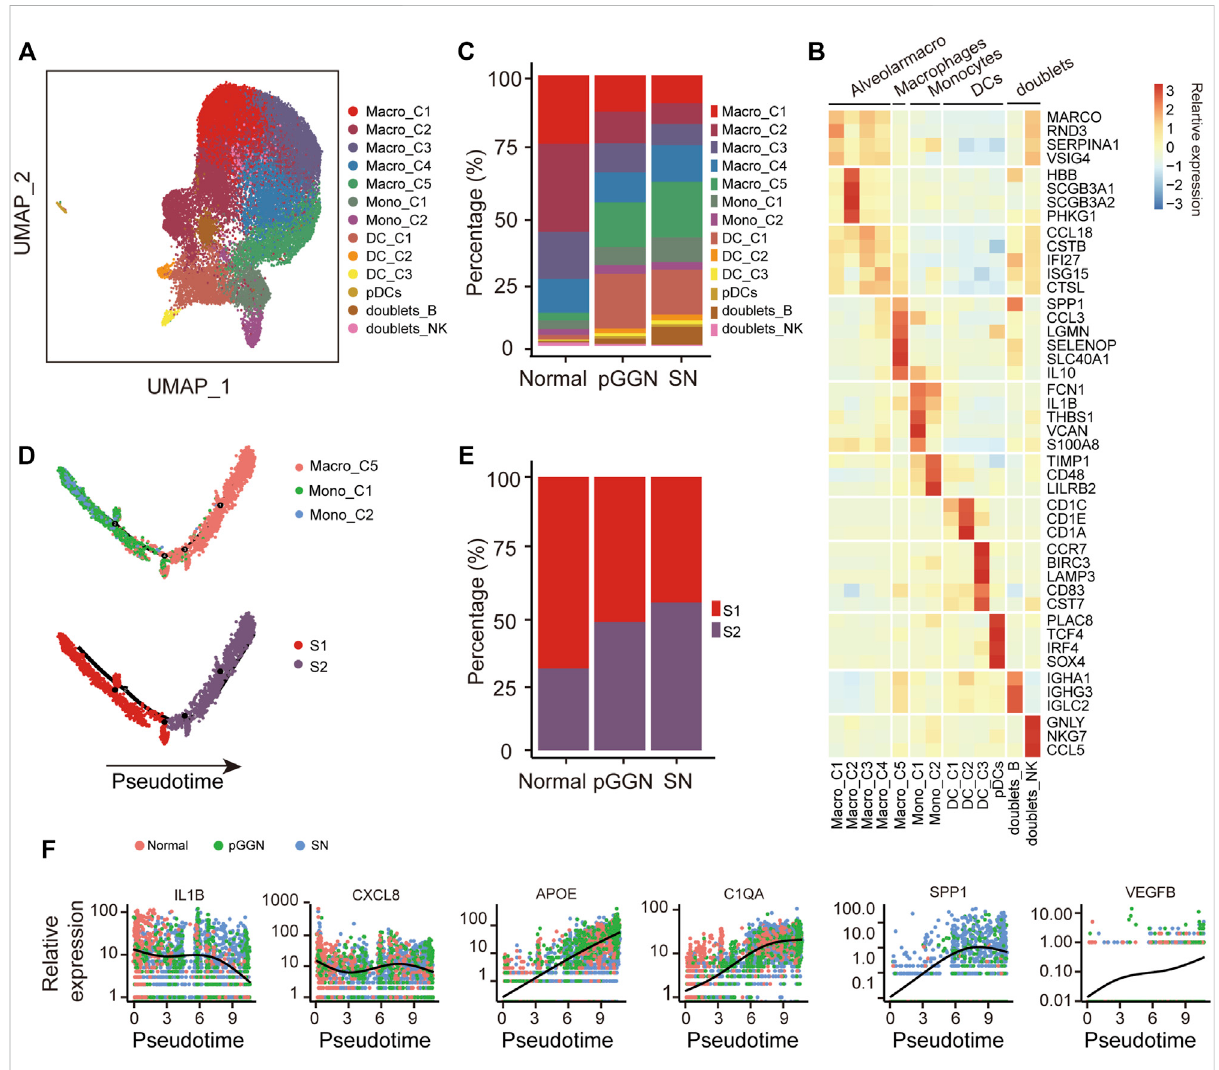
FIGURE 4 Progression of LUAD promoted by M2 macrophages. (A) UMAP plot of myeloid cells, colored by 14 cell subtypes. (B) Heatmap showed the expression ofcanonicalmarker genesin each myeloid cell subset. (C) The proportion ofcell subsets among each tissue origin,coloredbycell types. (D) Unsupervised transcriptional trajectory of monocytes and macrophages from Monocle2, colored by cell states (lower) and cell types (upper). (E) The proportion of cell states of the trajectory among each tissue origin. Red and purple represent S1 and S2 cell state, respectively. (F) The expressionchangesofM1-relatedgenes(i.e., IL1B and CXCL8 ),M2-relatedgenes(i.e., APOE and C1QA ),tumormalignancy-relatedgenes(i.e., SPP1 ), and angiogenesis-related genes (i.e., VEGFB ) with pseudo time trajectory. The relative expression was normalized by raw counts. The smooth black linerepresentsthekineticpatternsalongthepseudotimetrajectory,whichismodeledbyMonocle2.PureGGNs,SNs,andnormaltissuesarelabeled using different